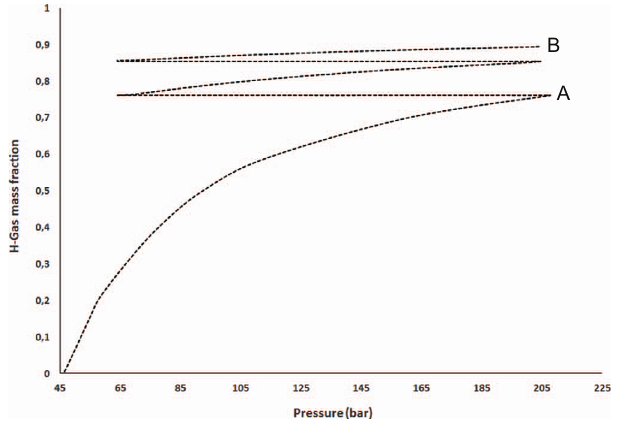
Fig. 10. H-gas mass fraction as function of the well-head pressure during conversion.